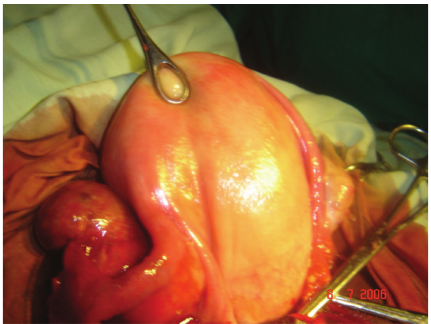
Figure 1: Showing bulky uterus and oedematous right adenexium that is proximal to the thrombosed right ovarian